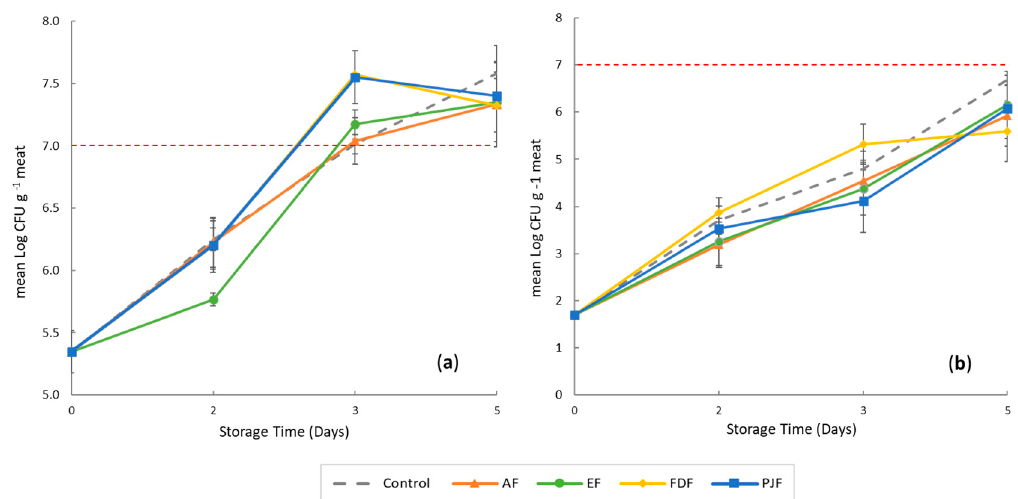
Figure 2. Effect on microbial load of alginate film and alginate film with microparticles and pineapple peel powder during five days of storage of meat at 4 °C. ( a ) Total aerobic mesophilic bacteria and ( b ) Pseudomonas spp. Alginate film with microparticles with encapsulated hydroalcoholic extract (EF), alginate film with pineapple-peel-juice microparticles (PJF), alginate film with freeze-dried peel powder (FDF), and control films only with alginate (AF).